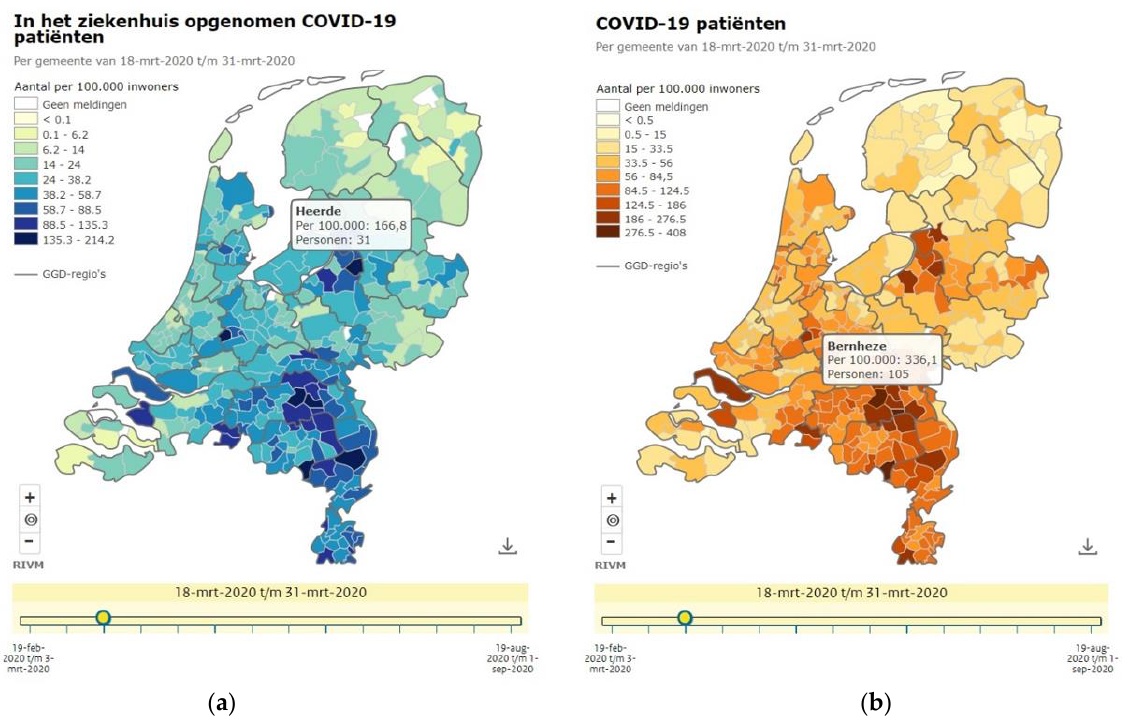
Figure 4. Number of hospitalized people ( a ) and COVID-19 cases ( b ) for the period 18–31 March 2020 per 100,000 inhabitants per municipality [23].